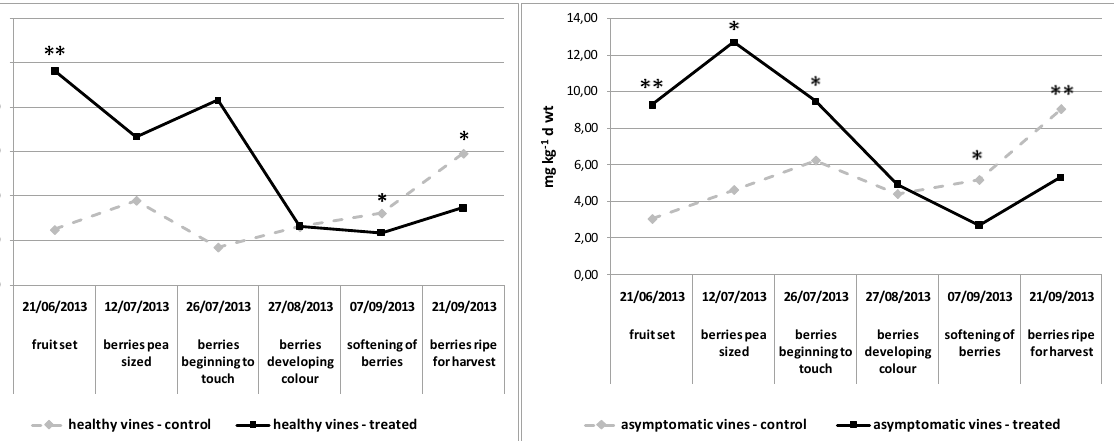
Figure 2. Mean amounts, in 2013, of trans -resveratrol Figure 2. Levels of trans -resveratrol in leaves of healthy vines in leaves from healthy grapevines, and from asymp- and of asymptomatic and symptomatic vines affected by GLSD treated and untreated with foliar fertilizer in the tomatic and symptomatic vines affected by GLSD, Controguerra vineyard in 2013. Each value is the mean of 6 that were either treated or untreated with foliar fer- replications of the leaf data individually obtained from 6 tilizer. Each value is the mean of six replications of vines for each grapevine status. The statistical analysis the leaf data individually obtained from six vines for separately compared leaf data from each grapevine group each grapevine status. The statistical analysis sepa- (healthy, asymptomatic and symptomatic; data comparison rately compared leaf data from each grapevine status of treated-untreated pairs) in every phenological growth (healthy, asymptomatic and symptomatic; data com- stage of the year (following Lorenz et al ., 1995). Value parison of treated and untreated pairs) in each phe- followed by the symbol statistically differ (* = P = 0.05; ** = P nological growth stage (following Lorenz et al ., 1995). = 0.01) respect to the other member of the pairs to the Student's t –test. Values for each pair of means followed by symbols are statistically different (* for P =0.05; ** for P =0.01) as indicated by Student’s t-